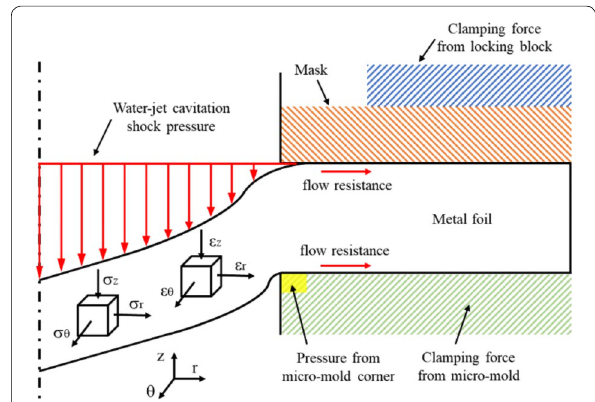
Figure 15 Force acting on metal foil during water-jet cavitation shock